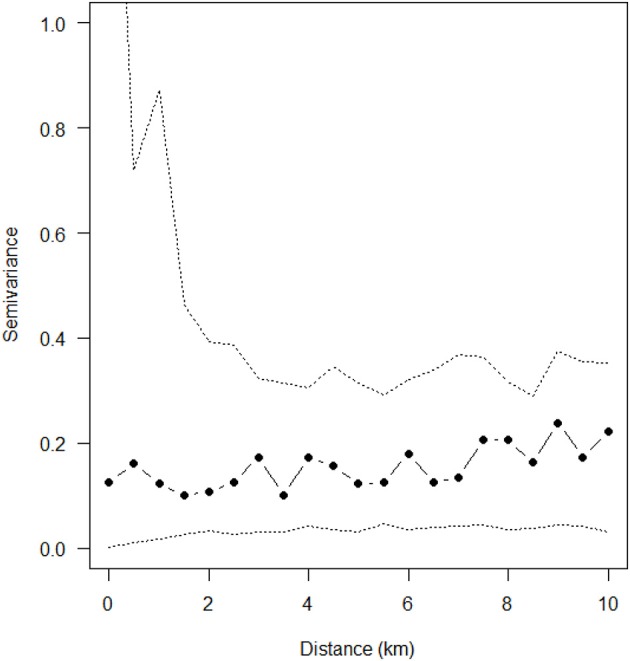
Empirical variogram fitted to the posterior mean of the standardized residuals from reduced Poisson point process model explaining sarcocystosis-positive farm density. Dashed lines show the pointwise 95% posterior intervals constructed from 999 simulated realizations of the fitted spatial model.